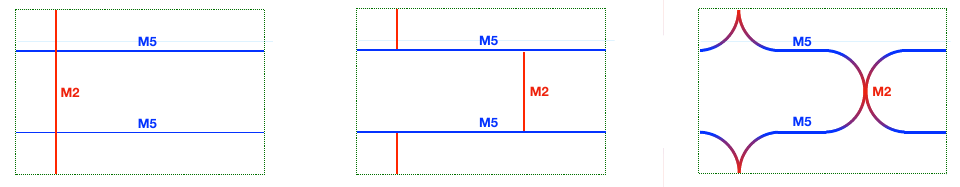
Figure 2 . The fractionation of M2 branes into strips and the super-maze: Before the fractionation (left panel) the M2 brane does not interact with the M5 branes, and can be freely taken away. After the fractionation, each strip of the M2 branes can move independently, giving the naïve configuration in the middle panel. However, the M2 strips pull on the M5 brane, creating the super-maze depicted in the right